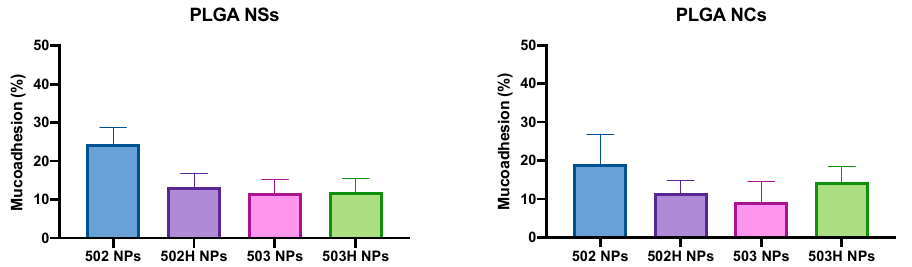
Figure 15. Ex vivo mucoadhesion data for PLGA-based nanoparticles. A one-way ANOVA analysis was applied for the PLGA NSs, showing no differences among the formulations ( p > 0.05), except for the 502 PLGA NSs, which showed a higher mucoadhesion than the rest, being statistically significant ( p < 0.02). Nevertheless, the same one-way ANOVA analysis was applied for the PLGA NCs, and no significant differences were observed between the prepared formulations, even for the 502 PLGA NCs compared to the others ( p > 0.05).